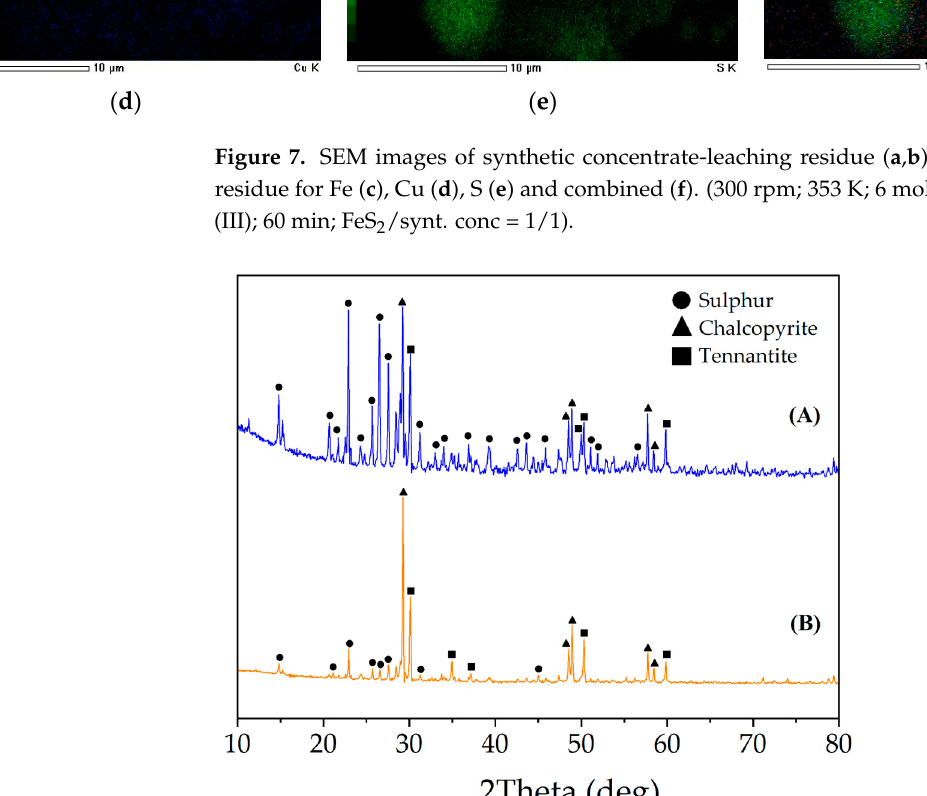
Figure 8. XRD patterns after synthetic concentrate dissolution in HNO 3 solution without ( A ) and with ( B ) the additive of FeS 2 . (300 rpm; 353 K; 6 mol/L H 2 SO 4 ; 0.018 mol/L Fe (III); 60 min). SEM images (Figure 9) of the material after dissolution for 15 min (bend point in Figure 5 for Cu 12 As 4 S 13 and CuFeS 2 ) coupled with EDX analysis (Table 2) suggest that most of the S ◦ was formed towards the end of this period and the subsequent dissolution of the material occurs at its coating by S ◦